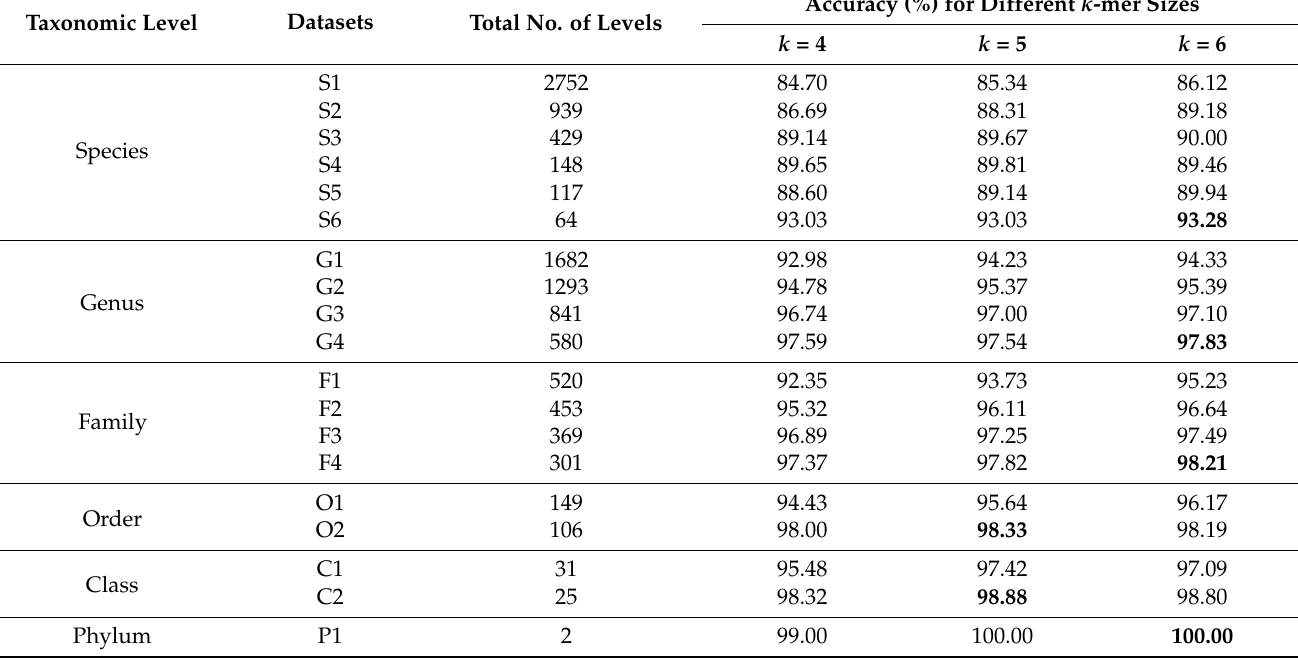
Table 5. Average classification accuracy (%) of CNN model with varying k -mer sizes for balanced datasets at all taxonomic levels. Accuracy values obtained from the test dataset are presented in the table, and highest accuracies at each level are highlighted in